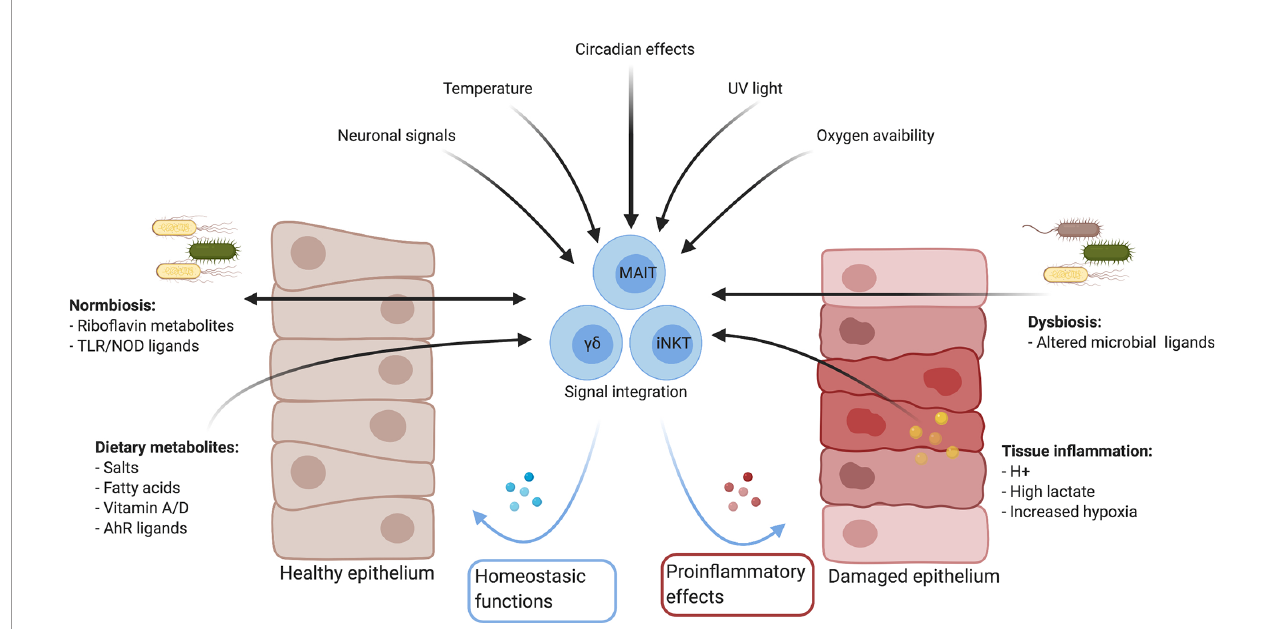
FIGURE 1 | Summary of mucosal environmental factors which could in fl uence immune responses directly and indirectly. Created with